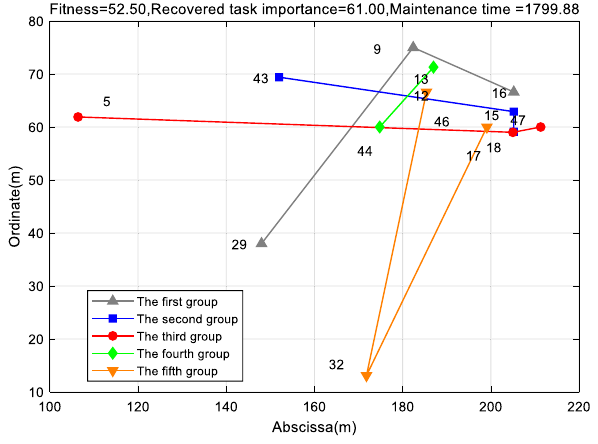
Fig. 14 Recovery strategy of improved genetic algorithm on improved quotient